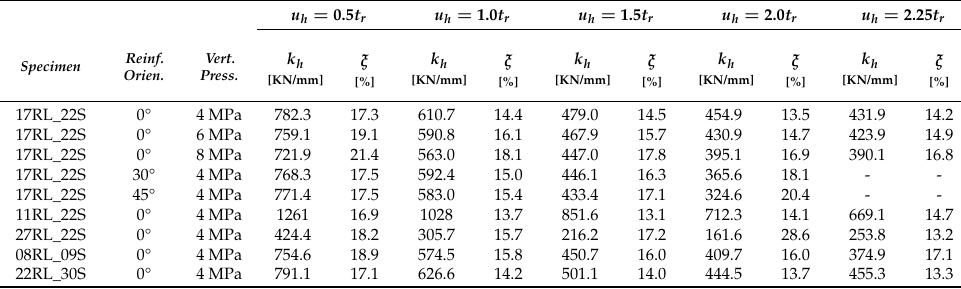
Table 3. Predicted horizontal mechanical properties.